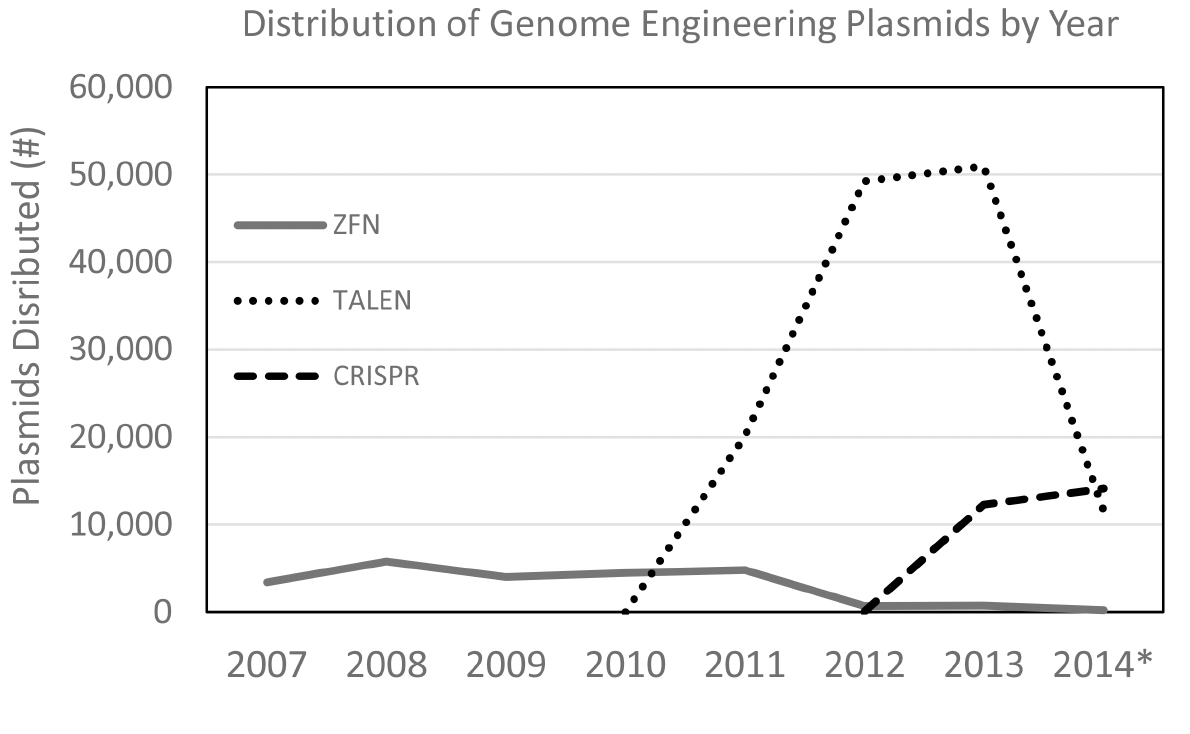
Figure 3. Dissemination of genome engineering technologies through plasmid sharing. Number of plasmids distributed for implementing zinc finger (ZFN)-, transcription activator-like effector nuclease (TALEN)-, or CRISPR-mediated genome engineering technologies. Note that various ZFN and TALEN assembly technologies require kits of plasmids ranging in size from 12 to as many as 834 plasmids (TALEN kit). CRISPR technology implementation requires a few individual plasmids. These data represent all plasmids distributed. *2014 totals reflect the number of distributed plasmids as of August 20, 2014.